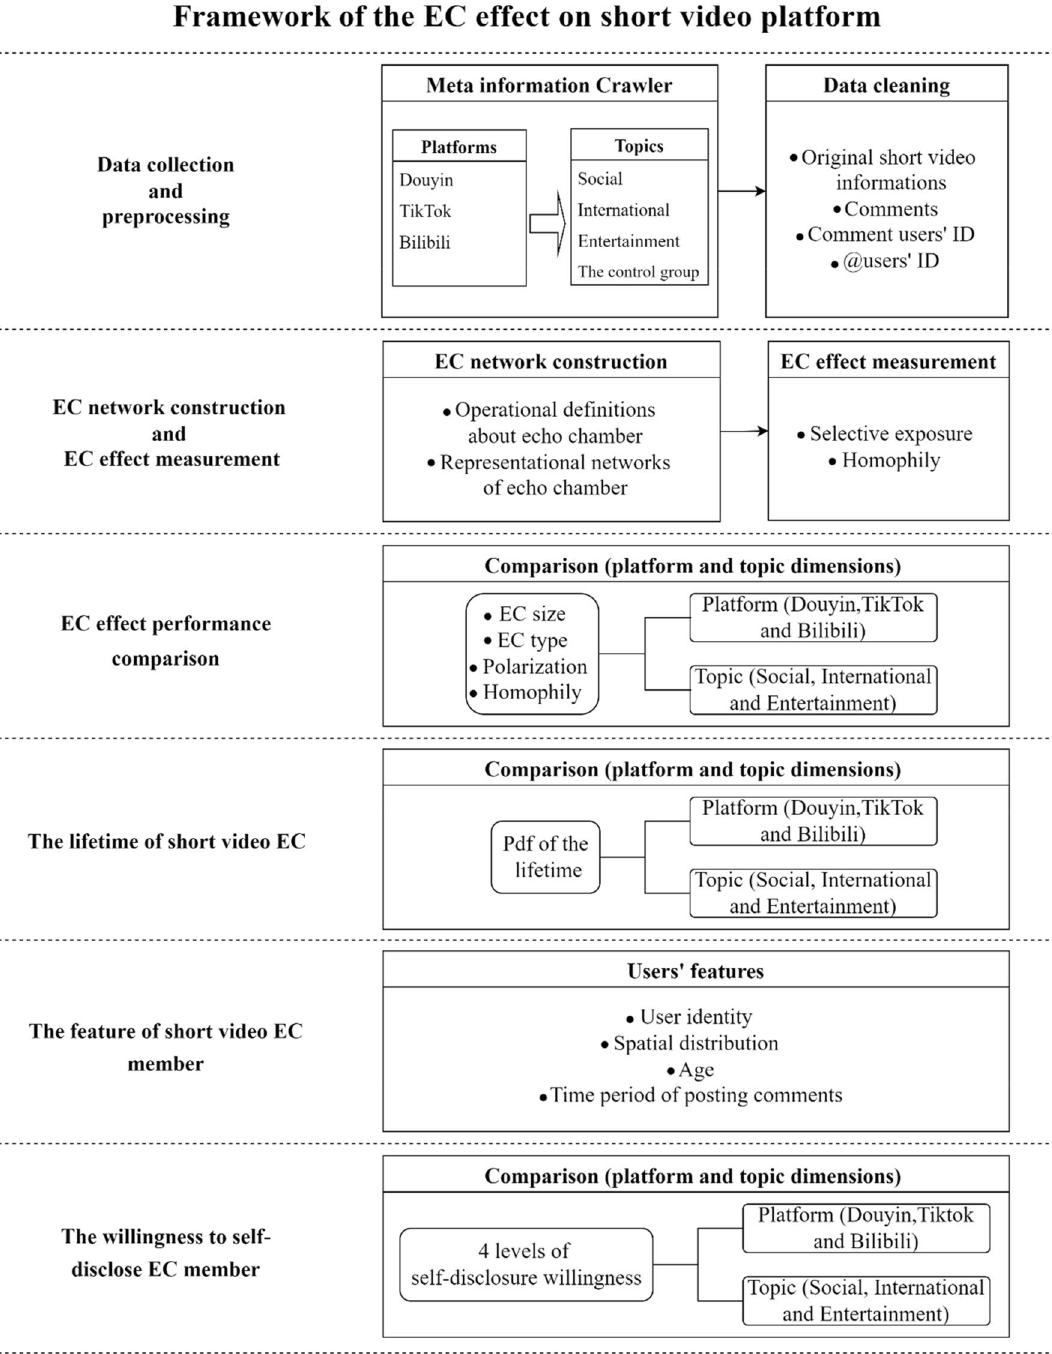
dataset. Data cleaning is separated into three steps: (1) reduce data noise via data filtering, removing duplicates, deleting blank and invalid text, removing hyperlinks, (2) eliminate meaningless ultrashort tweets and tweets